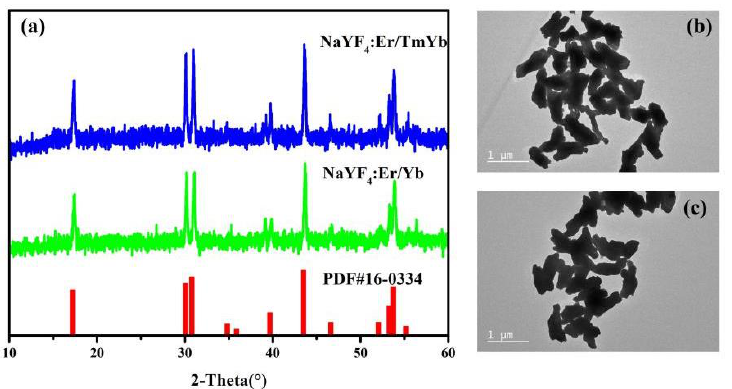
Figure 1. ( a ) XRD patterns of NaYF 4 : Er/Yb and NaYF 4 : Er/Tm/Yb phosphors; TEM images of ( b ) NaYF 4 : Er/Yb and ( c ) NaYF 4 : Er/Tm/Yb phosphors (the scale bare is 1